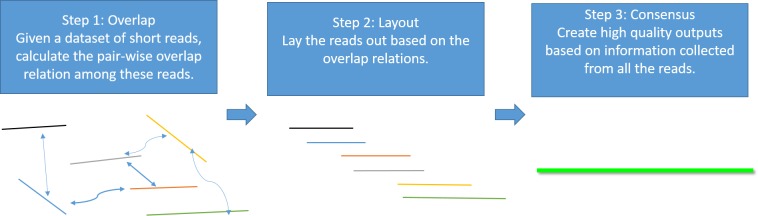
A standard Overlap-Layout-Consensus genome assembly pipeline.